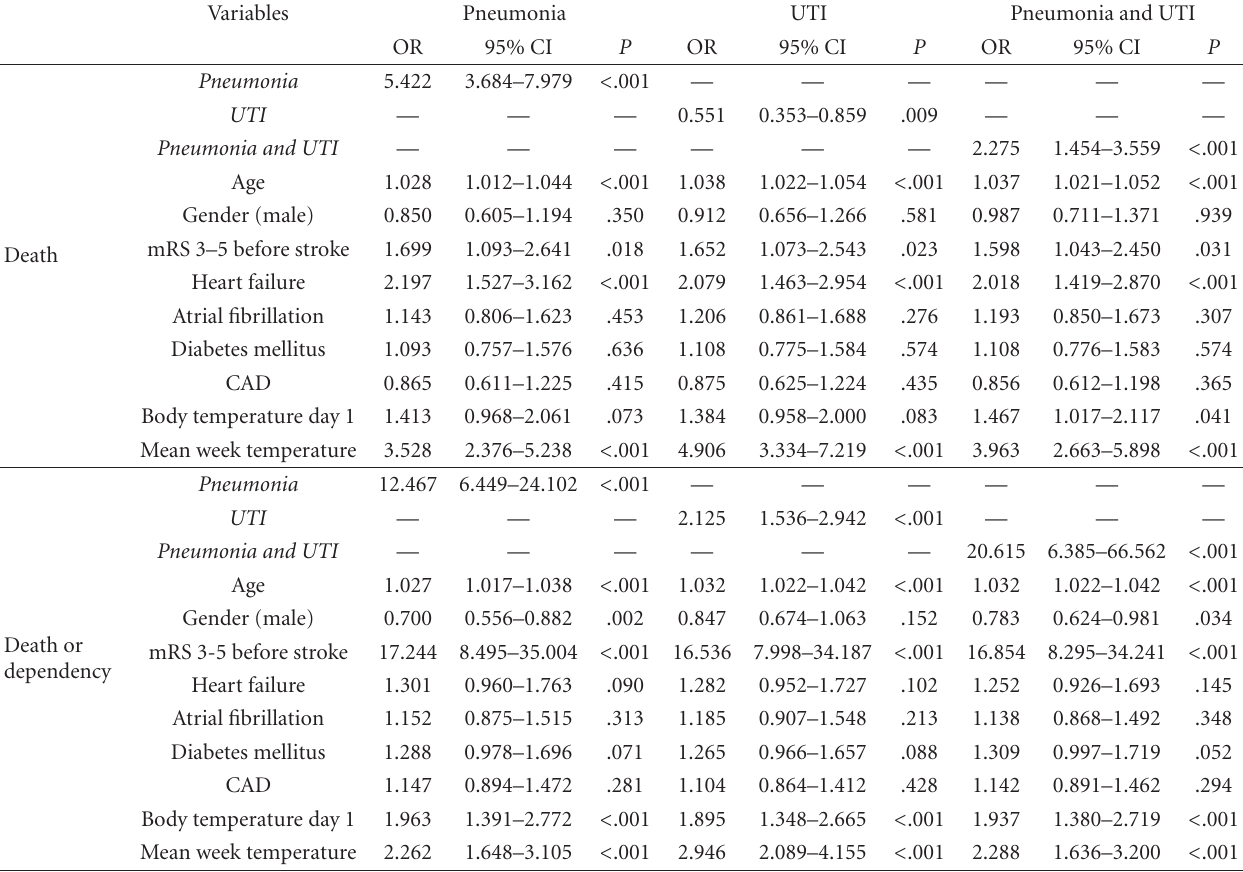
Table 4: Logistic regression for poor 30-day outcome (in-hospital